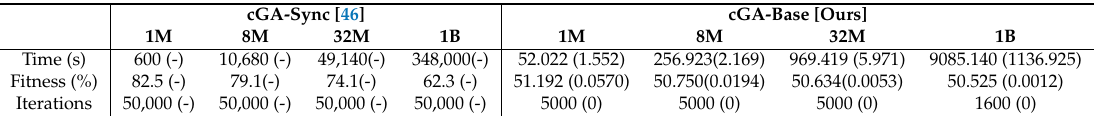
Table 4. Synchronous binary cGAs: comparison on the OneMax problem (mean across 10 runs, std. dev. in parentheses). The symbol ‘-’ indicates data not provided in [46].